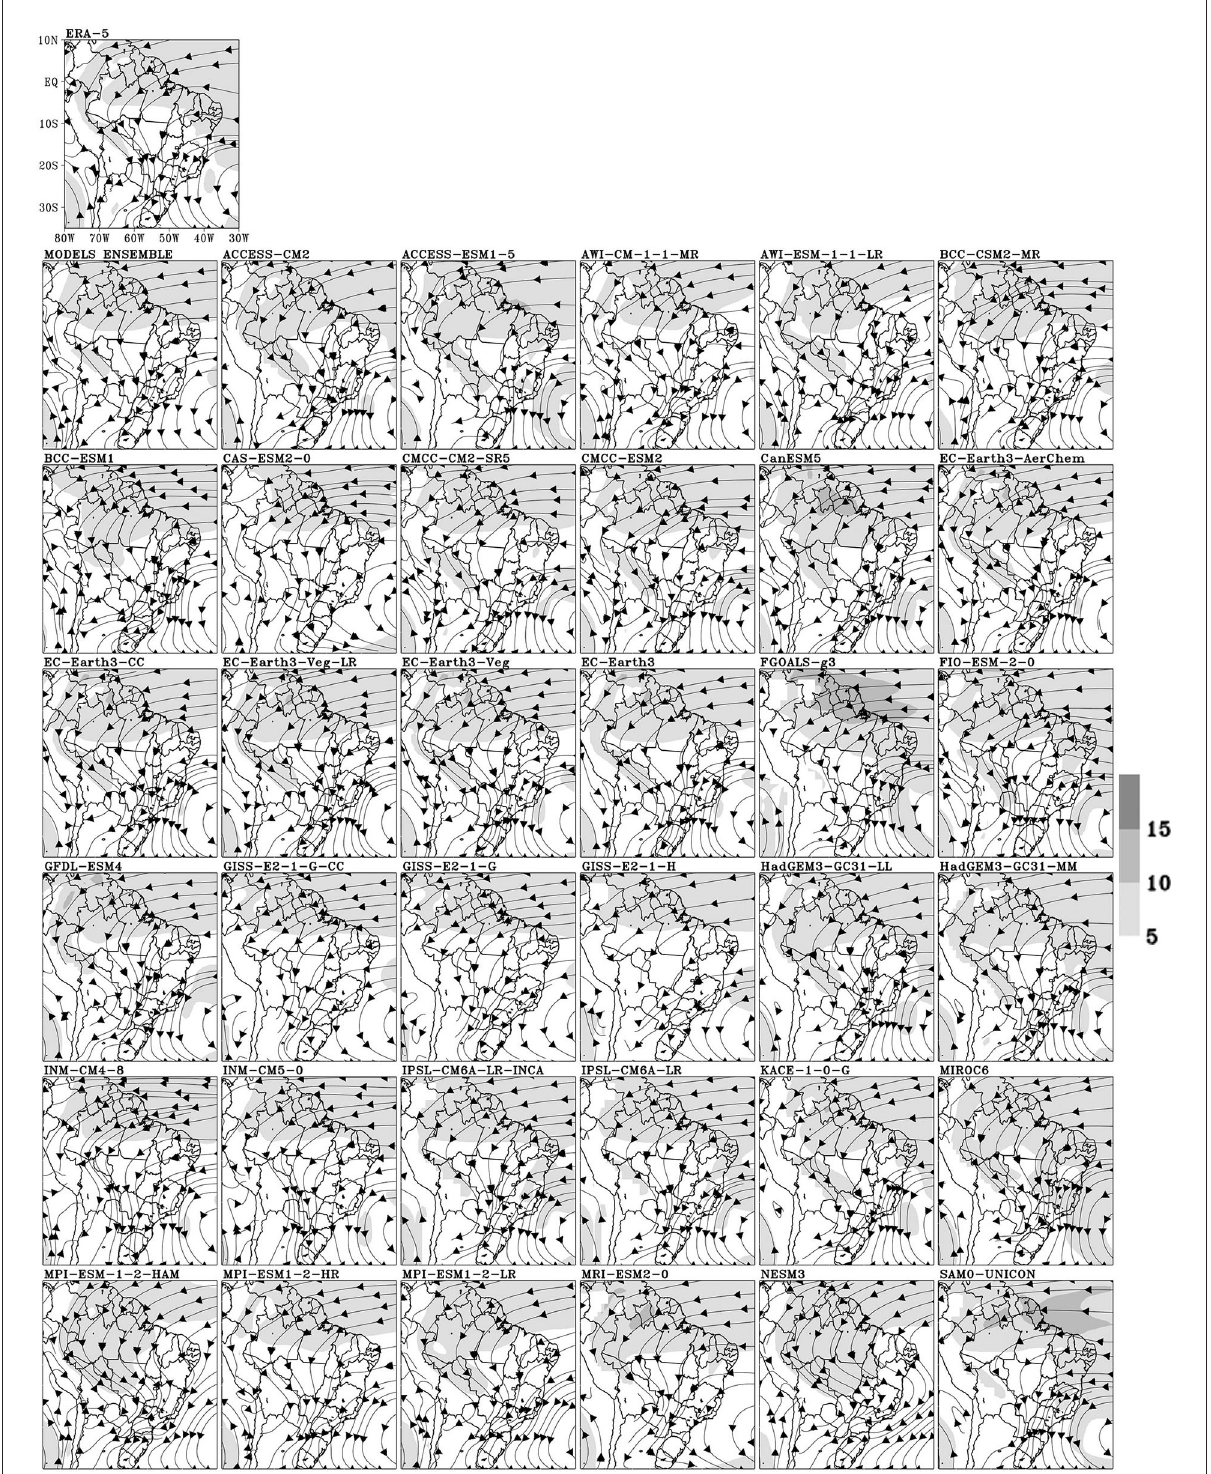
FIGURE2 Streamlines and magnitude of climatological winds (m/s) at 850 hPa simulated by the multi-model ensemble mean, individual CMIP6 models, and ERA-5 reanalysis (top left) for austral summer (DJF) during the historical period. The shaded regions represent wind magnitude starting from 5 m/s while the vector shows the wind